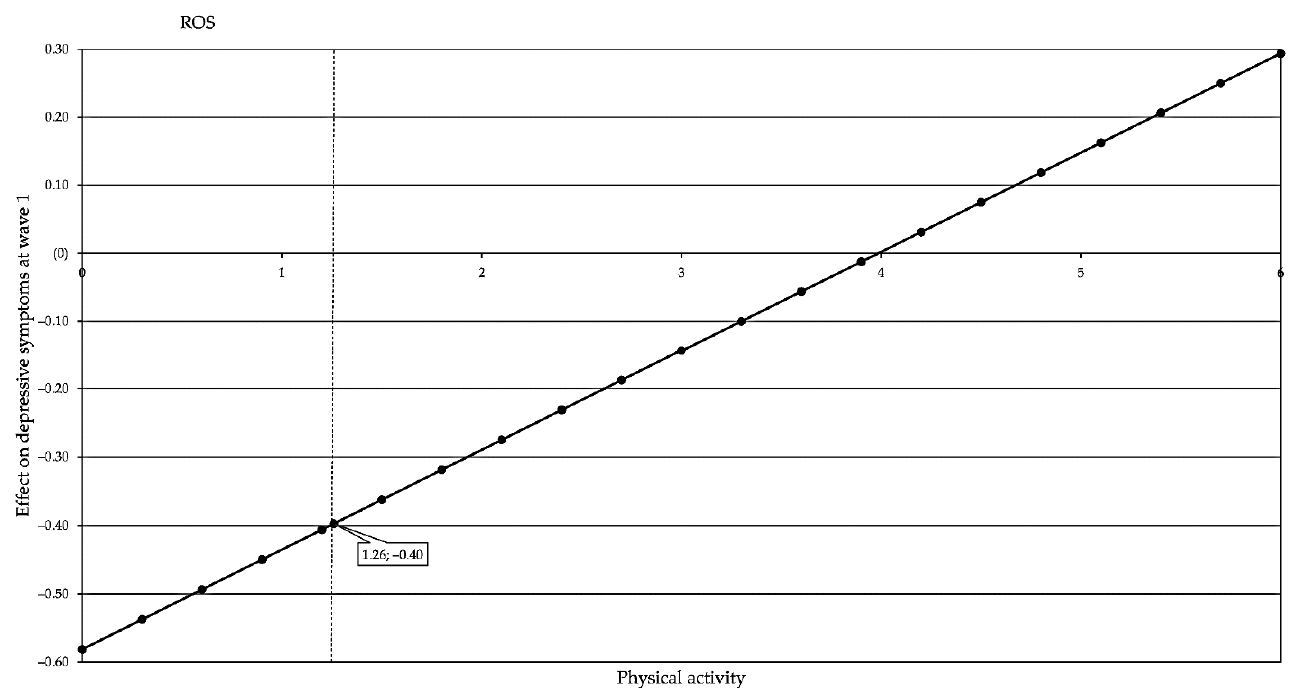
Figure 3. Region of significance (RoS) for the conditional effect of BDNF rs6265 on number of depressive symptoms in wave 1 at different levels of physical activity.